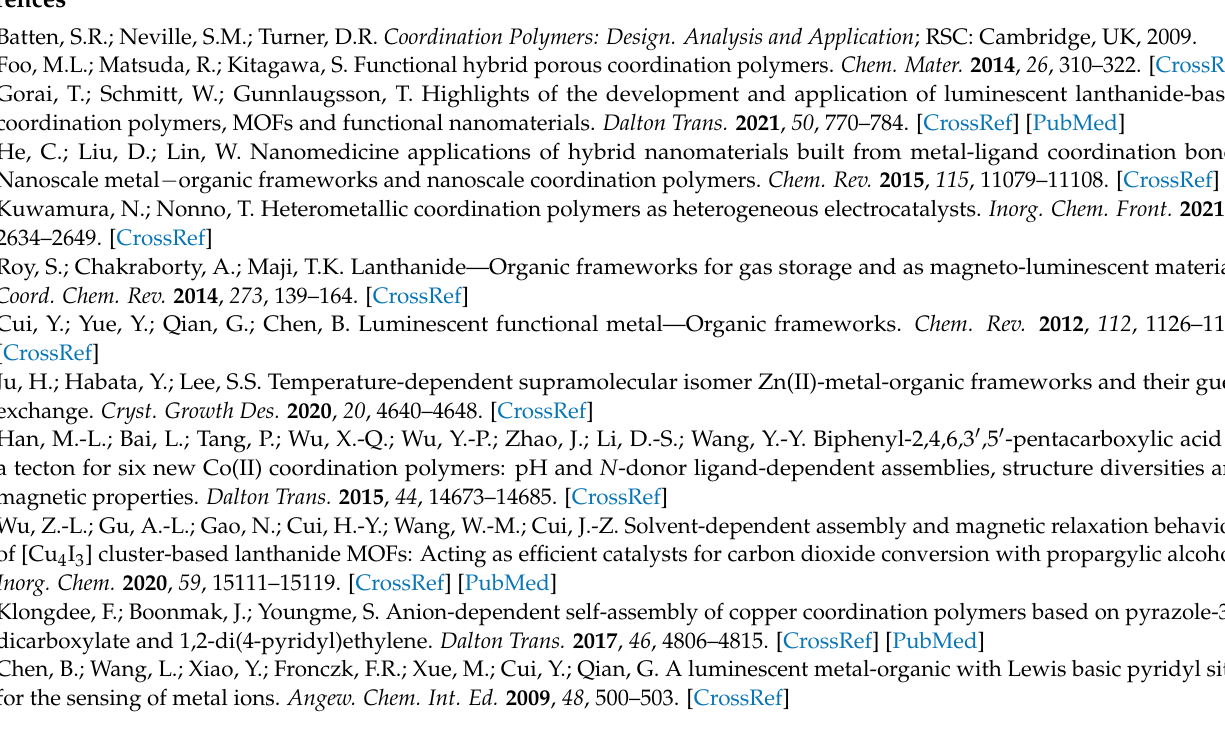
Figure S2: View of C ··· H- π interactions for 2 , Figure S3: Solid-state excitation spectrum for 2 , Table S1. Summary of crystal data and structure refinement for 1 and 2, Table S2: Selected bond lengths (Å) for 1 , Table S3: Hydrogen-bond geometry (Å, ◦ ) for 1 , Table S4: Selected bond lengths (Å) for 2 , Table S5: C ··· H- π interactions (Å, ◦ ) for 2